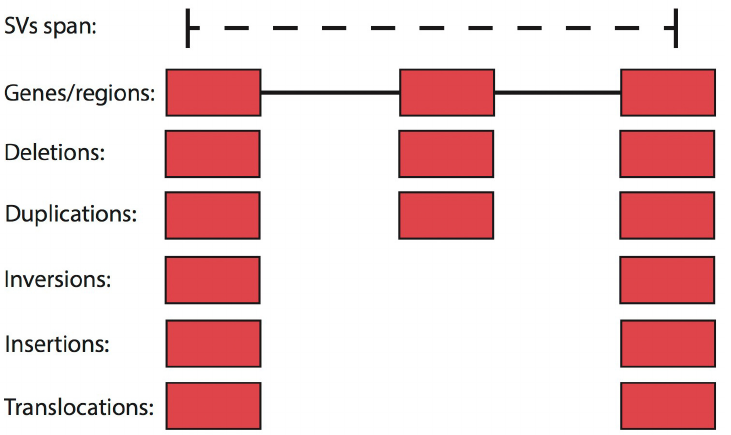
Figure 1. SV type specific overlap schema of SURVIVOR_ant to identify which genomic annotations overlaps with which type of SV. By default SURVIVOR_ant takes 1kbp surrounding the start and stop coordinates into account. Furthermore, for deletions and duplications we take the overlapping regions into